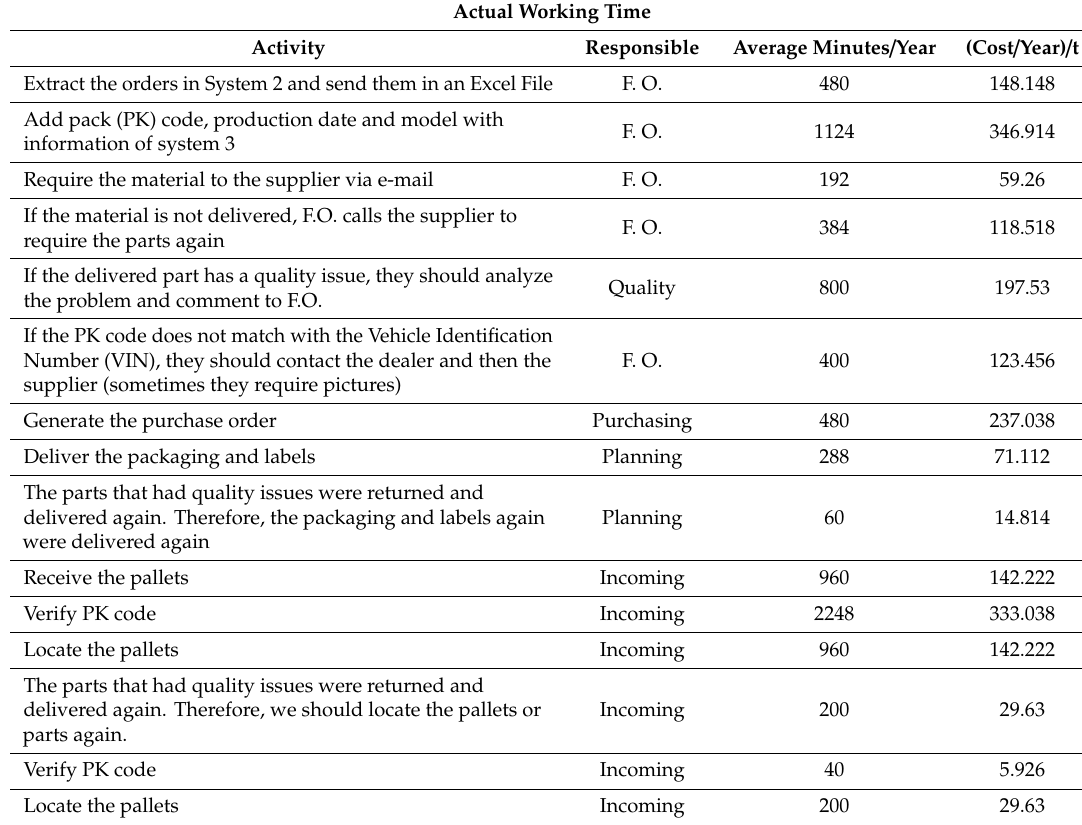
Table 2. List of activities performed by XYZ.